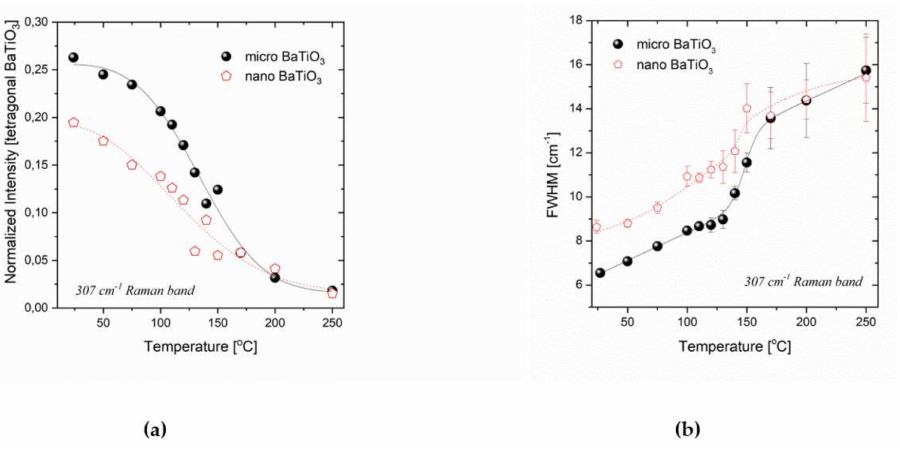
Figure 9. Normalized intensity ( a ) and FWHM of the 307cm − 1 band ( b ) as a function of temperature, for the micro- and nano-sized BaTiO 3 particles.